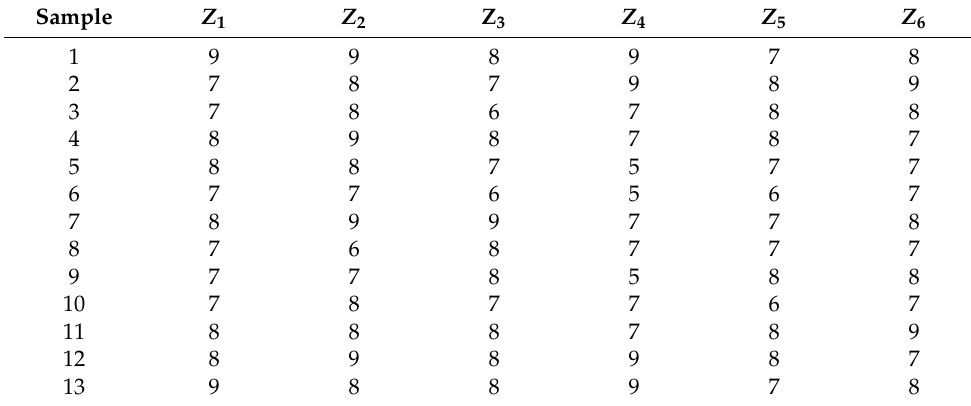
Table 8. Testing results of characteristic parameters of TVG.